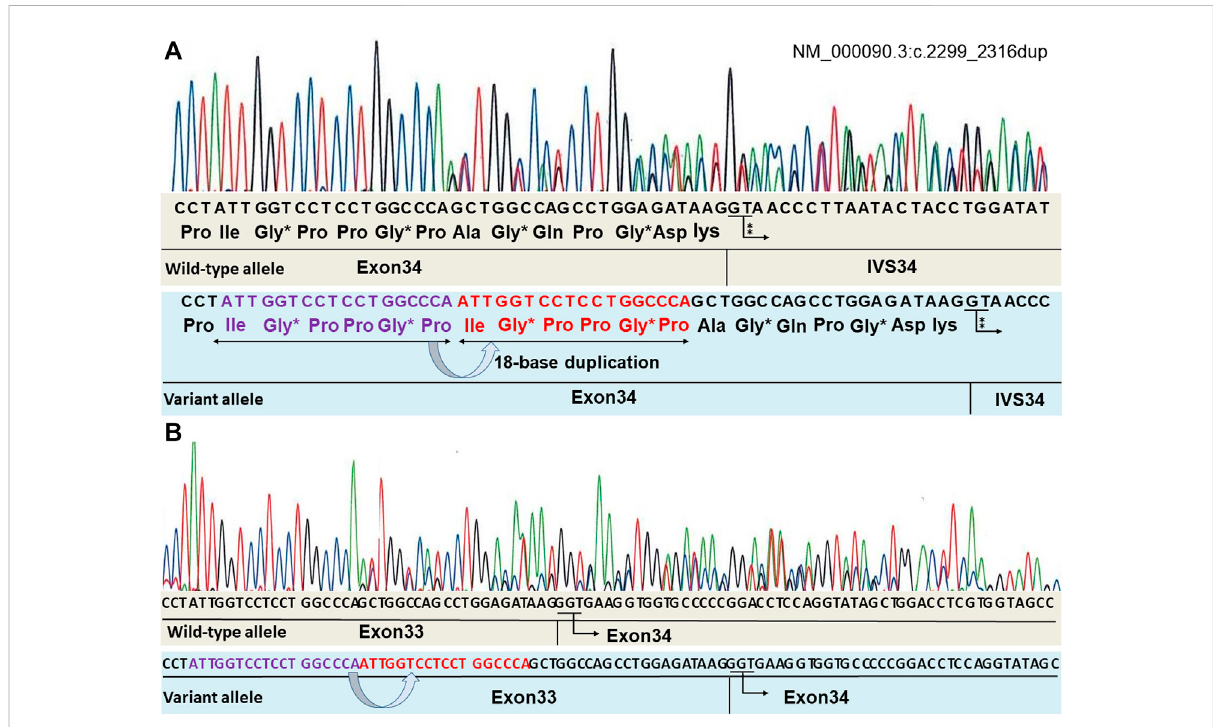
FIGURE 2 Mutation analysis of the COL3A1 genomic DNA identi fi ed a variant (NM_000090.3:c.2299_2316dup). The repeating sequence of [Gly-X-Y] is retainedinthevariant allele. “ * ” indicates Glypositionedinatripletrepeatsequence. “ ⁑ ” indicatesGT, indicating thebeginning oftheintron (A) .RNA sequencing is shown in (B) . mRNA obtained from the fi broblasts of the patient was converted to cDNA using reverse transcriptase, and Sanger sequencinganalysisofthecDNAwasperformed.Therearenoabnormalnucleotidesintheborderofexons33 – 34.Bothalleleshavethenormal subsequently transcribed exon 34 without an exon